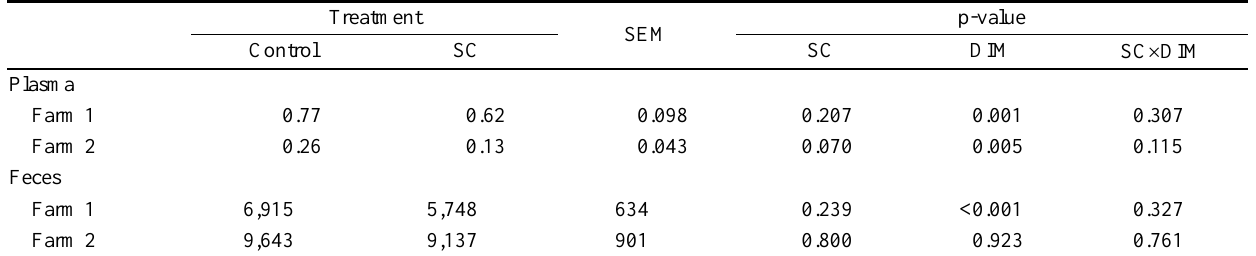
Table 5. Effect of yeast culture supplementation (SC) 1 on LPS concentration (EU/ml) 2 in plasma and feces